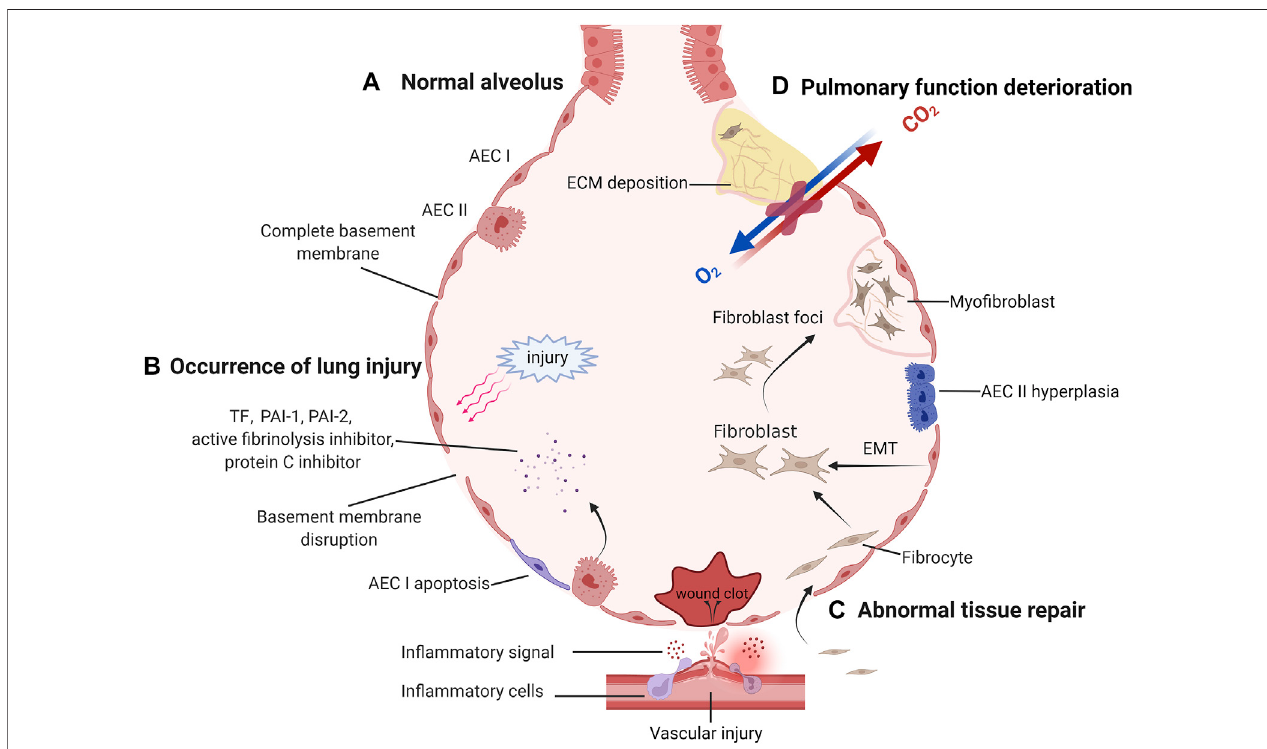
FIGURE 1 | The pathological process of idiopathic pulmonary fi brosis. (A) After normal alveoli are damaged and abnormally repaired, irreversible lung function deterioration occurs. Normal alveolus has a complete basement membrane and gas exchange function. (B) When the basement membrane continuity is disrupted by external injury, the damaged capillaries and activated AECs release in fl ammatory signals and coagulation factors, forming a local in fl ammatory microenvironment. (C) If the damage persists, abnormal repair will be initiated. Lung mesenchymal progenitors, fi brocytes recruited to the lung, and endothelial cells undergoing EMT can aggregate to form fi broblasts foci and differentiate into matrix-secreting myo fi broblasts. To compensate for the local blood supply to the alveoli, new blood vessels are gradually formed. (D) As fi broblast foci increased, more ECM was deposited and cross-linked together, triggering a deterioration in lung compliance and gas exchange